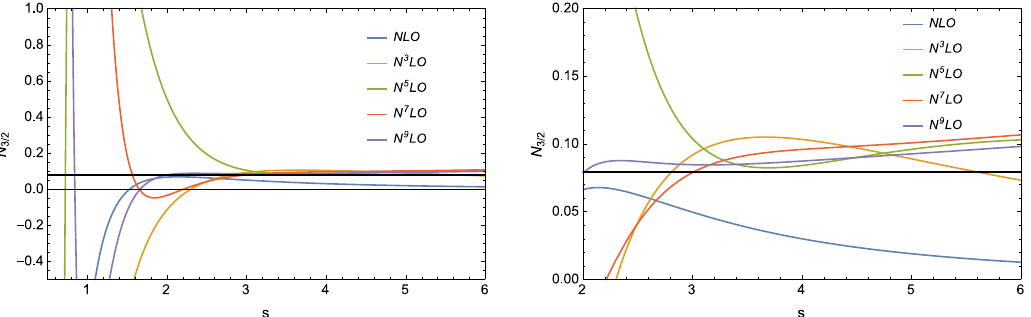
Figure 6 . Scale dependence of N determined from (cid:12)nite number of terms at NNLL. Black line 3 = 2 shows the exact answer obtained from the analytic formula. In the right panel, the range 2 (cid:20) s (cid:20) 6 is